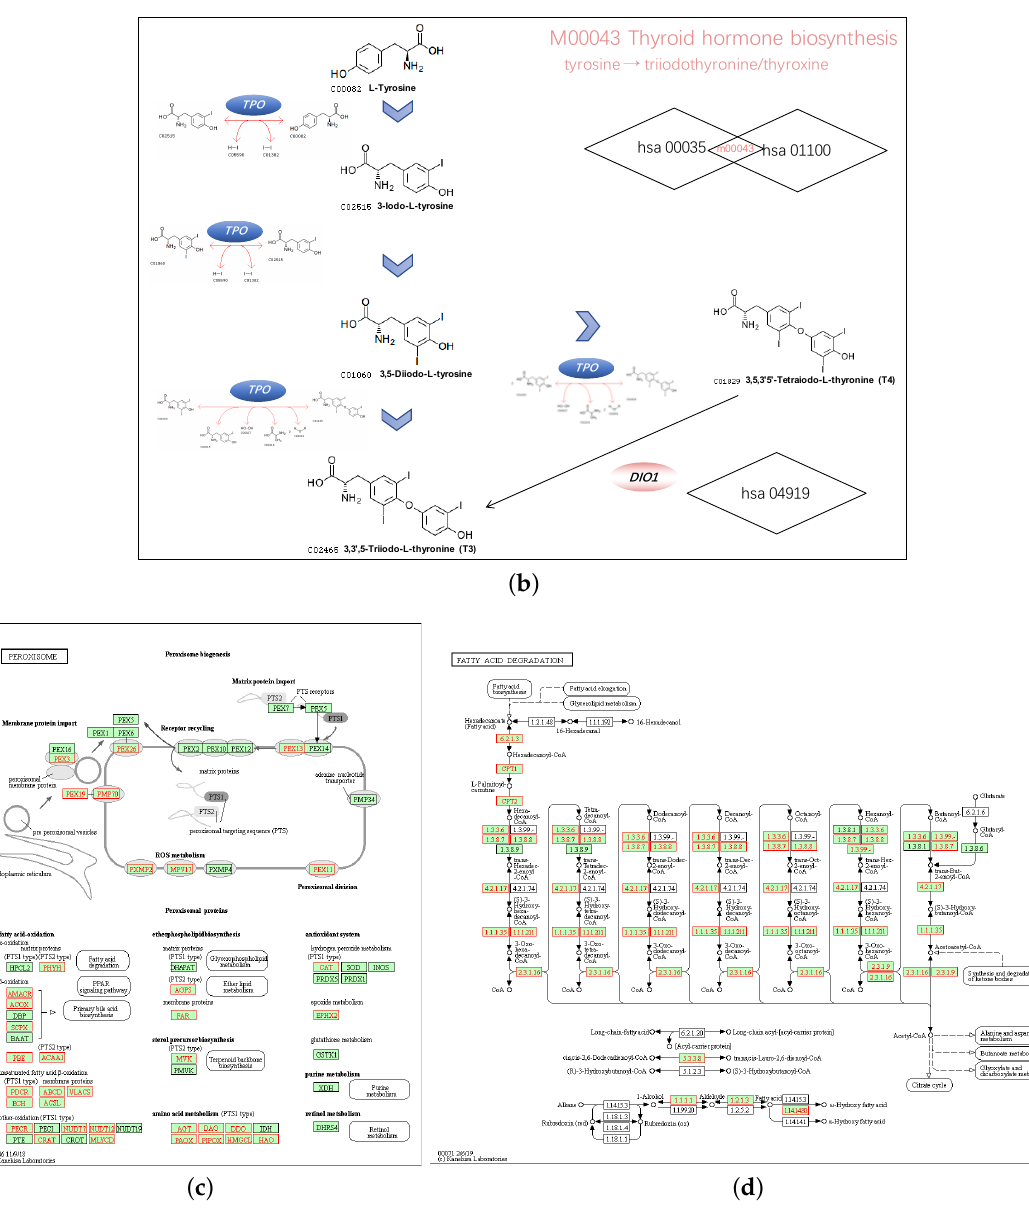
Figure 7. Pathways of interest. ( a ) GSEA results showing tyrosine metabolism, metabolic pathways, peroxisome and fatty acid degradation are differentially enriched pathways in LRRC19-related genes. NES, normalized enrichment score. ( b ) The relationship between DIO1 and Module 00043 Thyroid hormone biosynthesis. ( c ) KEGG pathway annotations of the peroxisome pathway. ( d ) KEGG pathway annotations of the fatty acid degradation pathway. Altered genes were denoted in